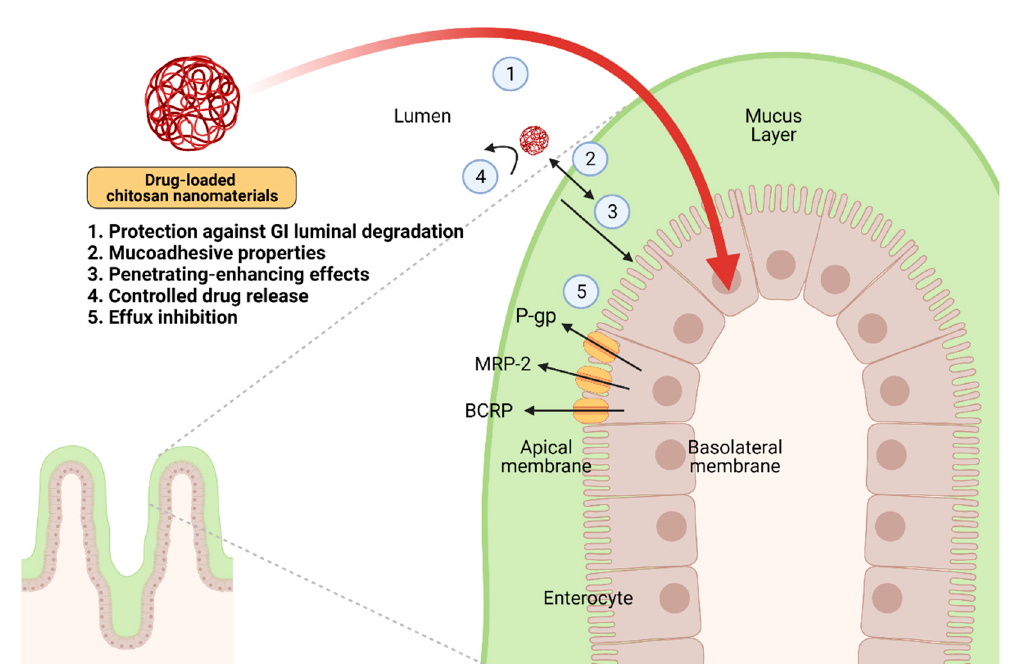
Figure 2. The mechanistic insights of the enhancement of drug absorption by drug-loaded chitosan nanomaterials in the intestine. The ideal properties of these nanomaterials include (i) protection against GI luminal degradation, (ii) mucoadhesion, (iii) permeation enhancement, (iv) controlled drug release, and (v) inhibition of P-gp, MRP-2, or BCRP. Abbreviation: P-gp, P-glycoprotein; MRP-2, multidrug resistance protein-2; BCRP, breast cancer resistance protein. Created with